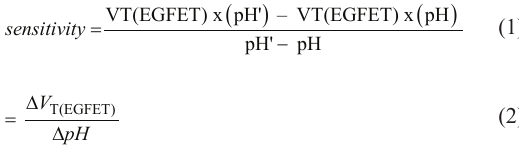
Figure 5. Voltammograms of WO ranging from 2 to 12.